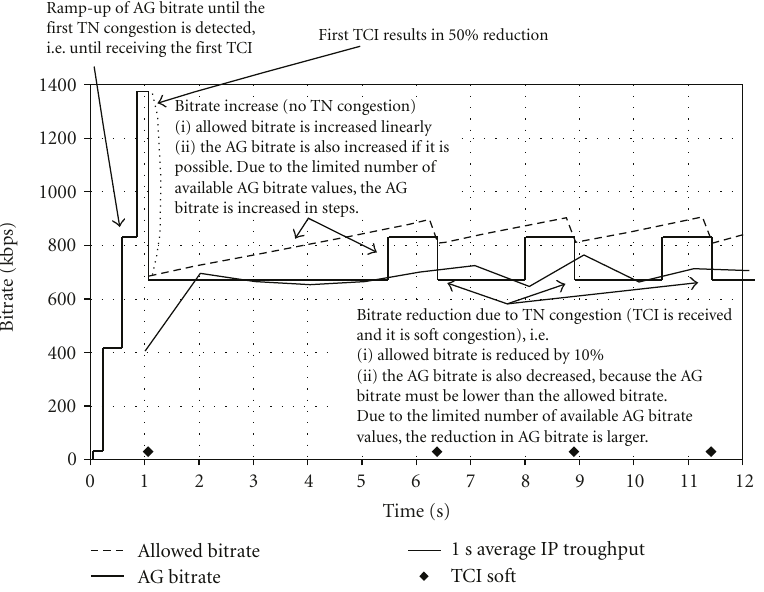
Figure 5: Flow control behavior in case of 1 user and 1Mbps